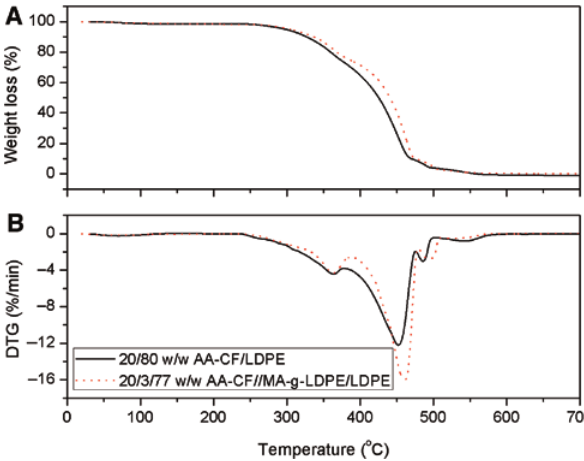
Figure 8: TG (A) and DTG (B) curves of AA-CF/LDPE composites at 20 wt% fiber loading with or without